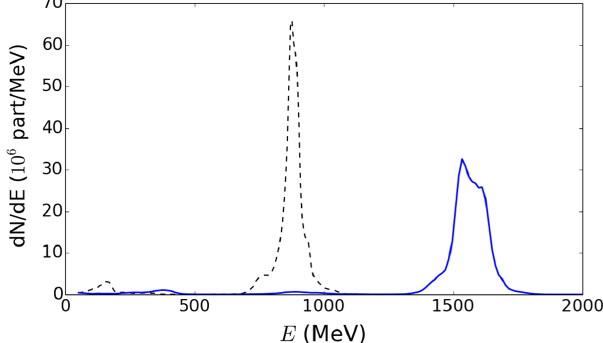
FIG. 6. Evolution of electron energy spectra in the blowout regime. Electron distribution after 9 cm of propagation (blue) and 4 cm (black dashed